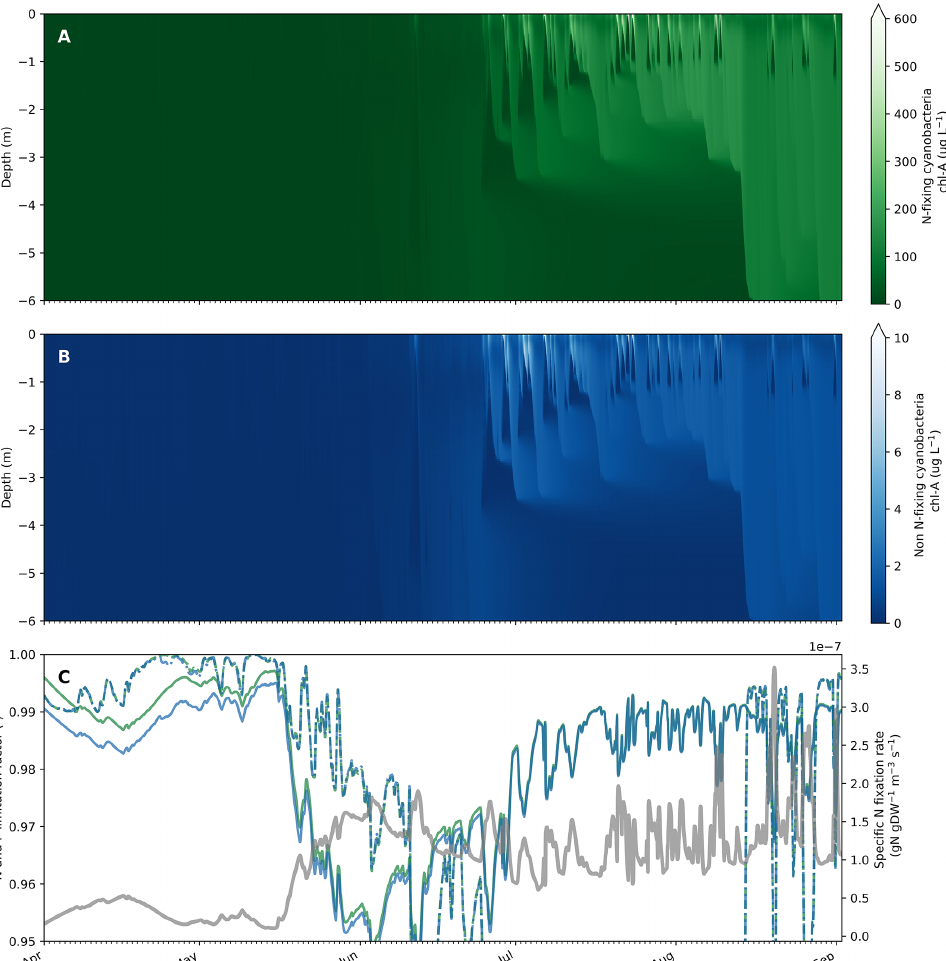
Figure 4. Example of simulated cyanobacteria, nutrient limitation and N fixation dynamics in Lake Bryrup from April to September 1994. Output of N-fixing and non-N-fixing cyanobacteria chl a concentrations from the upper 6m of Lake Bryrup (a, b) . C : N and P limitation factor (solid and dashed lines, respectively) for N-fixing and non-N-fixing cyanobacteria (green and blue lines, respectively) as well as the specific N fixation rate by N-fixing cyanobacteria (grey line, secondary y axis) in the surface model layer (surface to 0.5m). The phytoplankton group is nutrient-replete (N and/or P) or nutrient-depleted when the limitation factor is equal to 1 or 0, respectively. Table 2. Comparison of performance metrics between Chen et al. (2020) and the present study. WET (this study) Chen et al. (2020) R 2 RMSE R 2 RMSE Variable Calibration Validation Calibration Validation Calibration Validation Calibration Validation